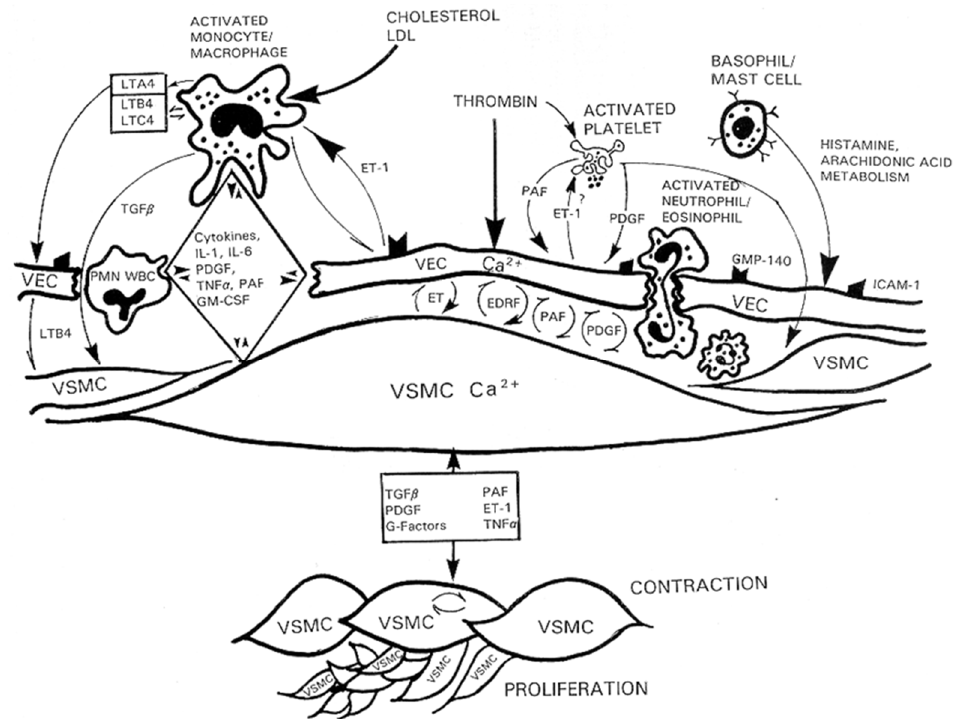
Figure 6. Activation of immune cells induces the release of factors that modulate the function and junctions between VECs, which permits the infiltration of activated neutrophils/eosinophils, and polymorphonuclear cells (PMN). The remodeling of the vascular endothelium induces the secretion of factors that induce either relaxation or contraction of VSMCs. The activated monocytes/macrophages and VECs’ released factors promote the proliferation of contractile and non-contractile VSMCs that characterize atherosclerosis (modified from Bkaily, 1994) [27].